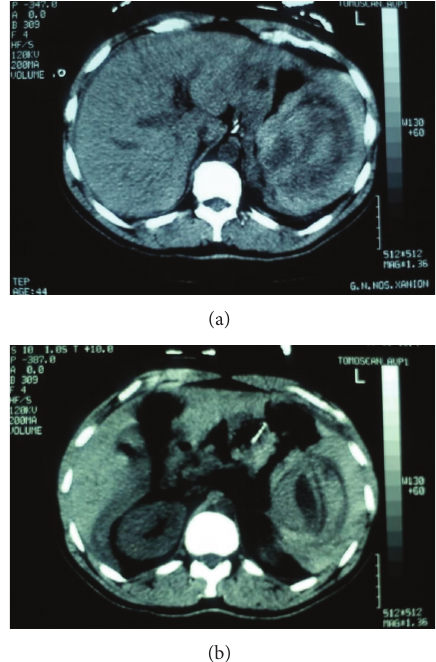
Figure 2: Axial computed tomography of the abdomen showing a ruptured spleen and